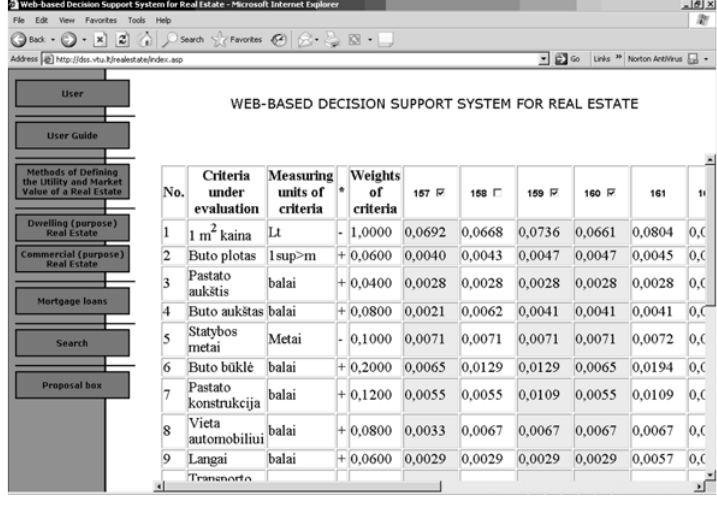
Figure 5. Selection of real estate objects for automated